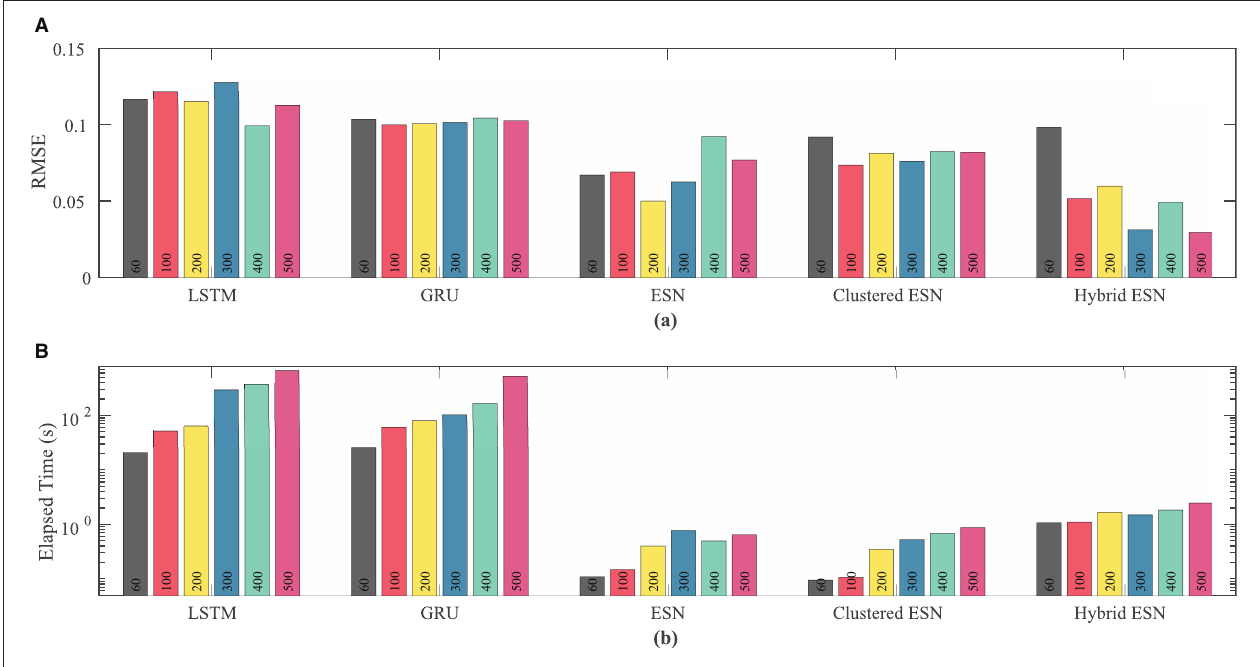
FIGURE 6 | Comparison of RMSE (A) and computational time (B) for each method and network size tested for the FK dataset.